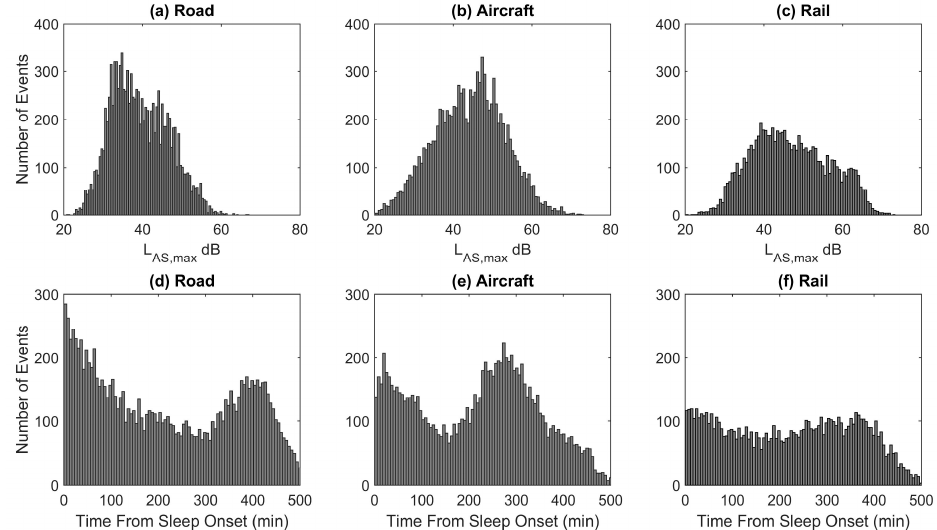
Figure 5. Distribution of indoor noise levels and the time of events relative to sleep onset for ( a , d ) road; ( b , e ) aircraft; and ( c , f ) rail events (all undisturbed noise events from the STRAIN and DEUFRAKO studies used for analysis).